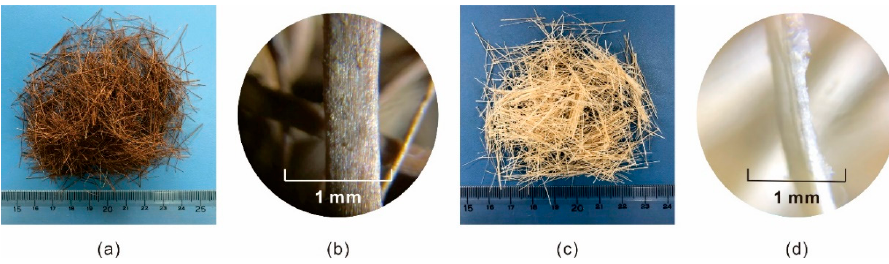
Figure 3. The images of fibers: ( a ) CF macro, ( b ) CF micro, ( c ) SF macro, and ( d ) SF micro. Table 2. The physical and mechanical properties of coir and sisal fibers.